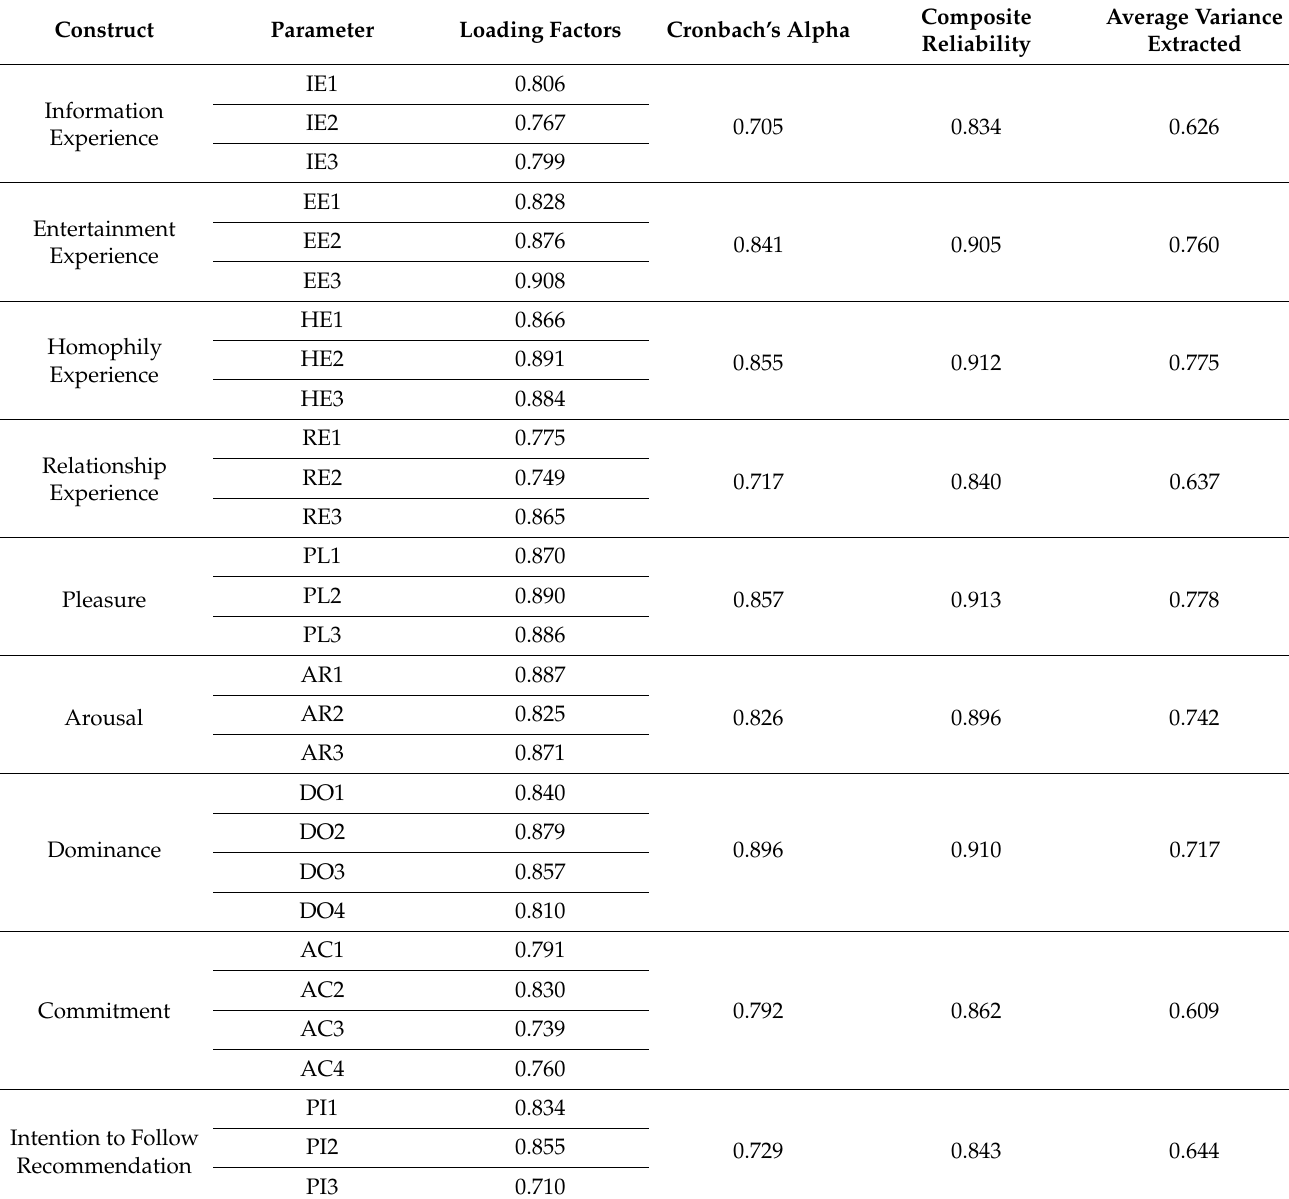
Table 4. Loading factors, Cronbach’s alpha, composite reliability, and average variance